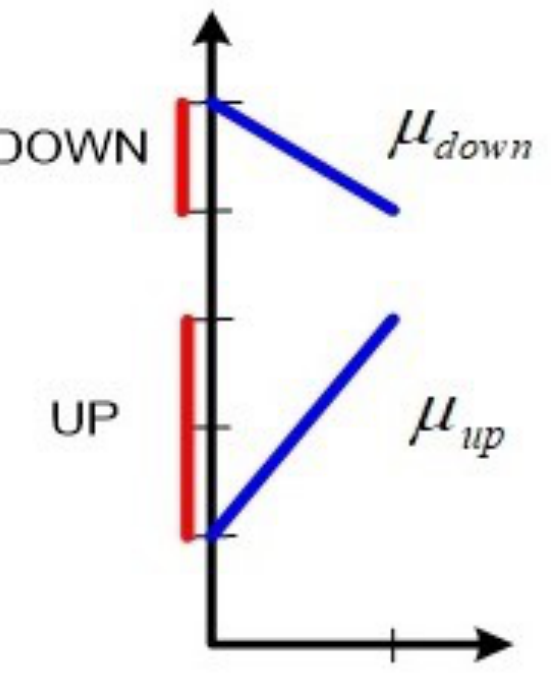
Figure 1. The functions up and down in Ordered Fuzzy Number representation.